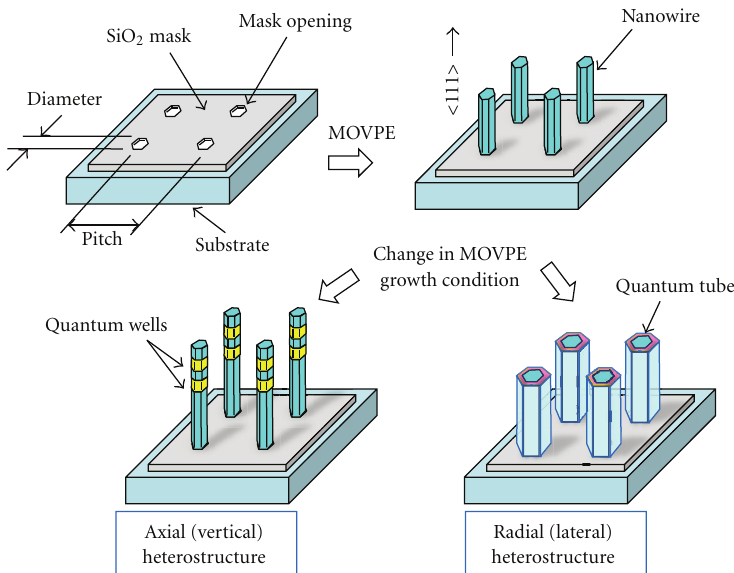
Figure 1: Schematic of process for forming heterostructure